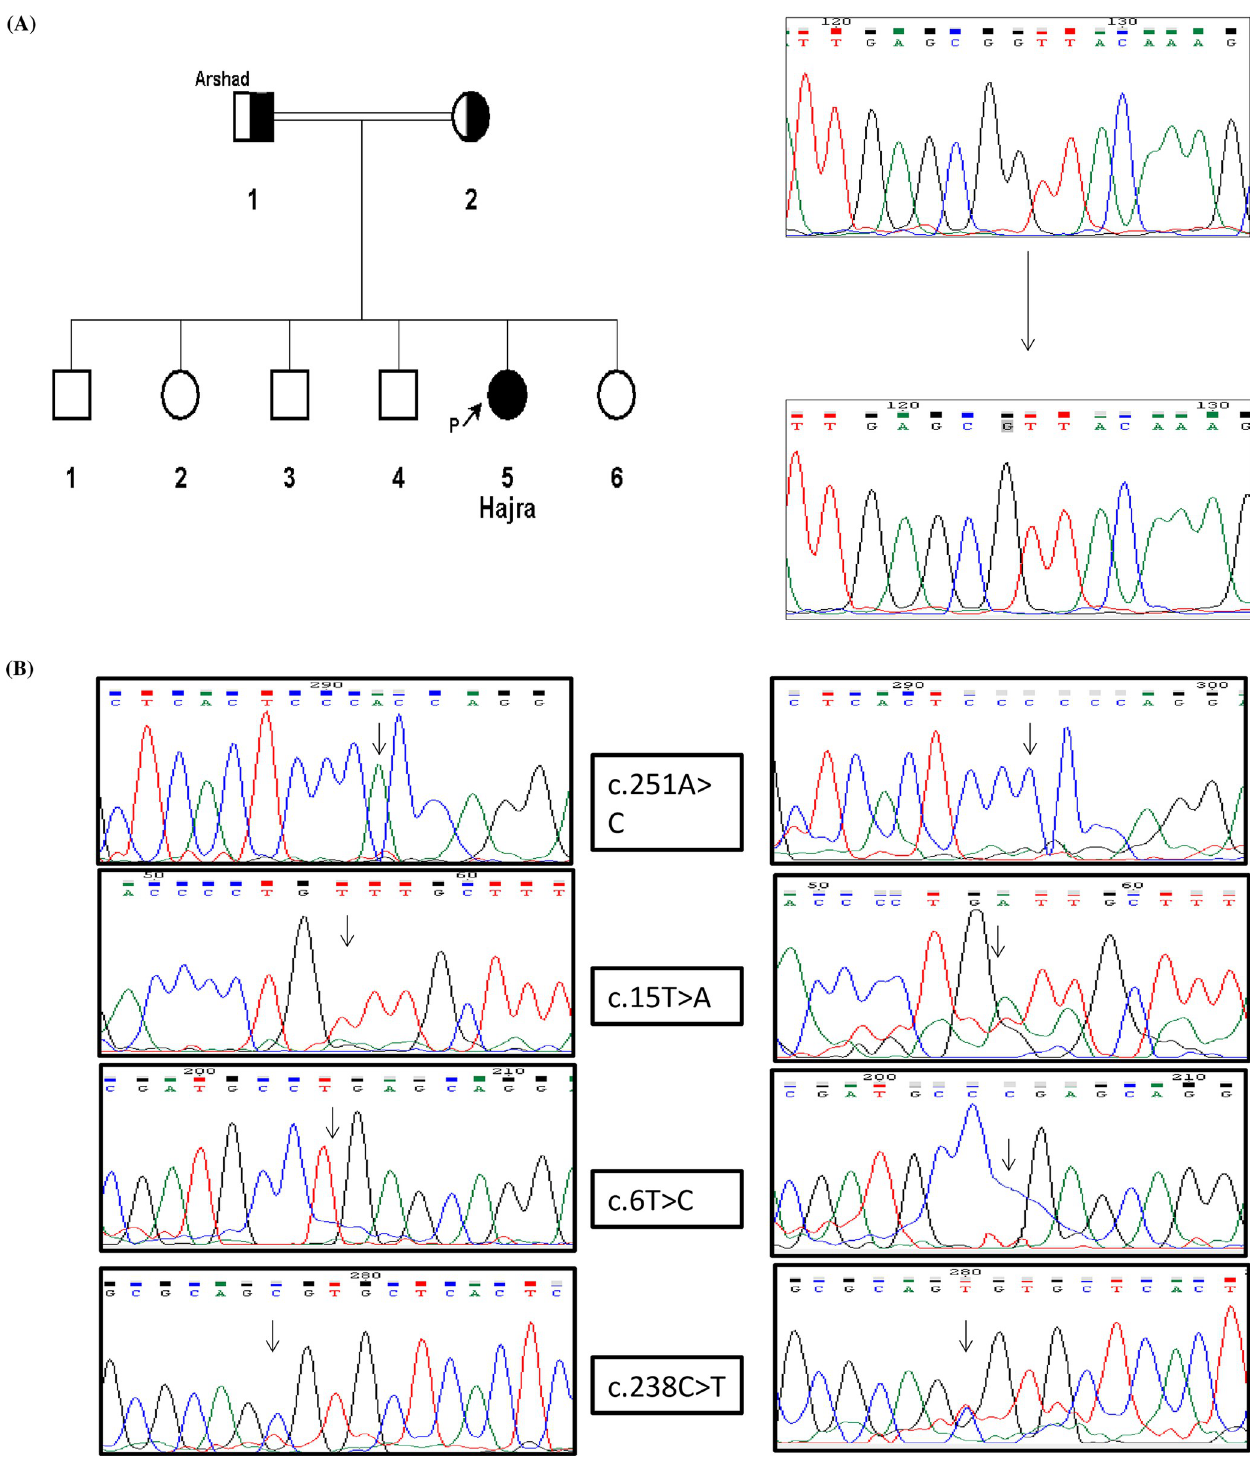
Fig 3. (A) Pedigree of family of Patient WD-1 and Chromatogram of variation found in exon2 of ATP7B and (B) Chromatograms for Novel Variants found in ATP7B gene.